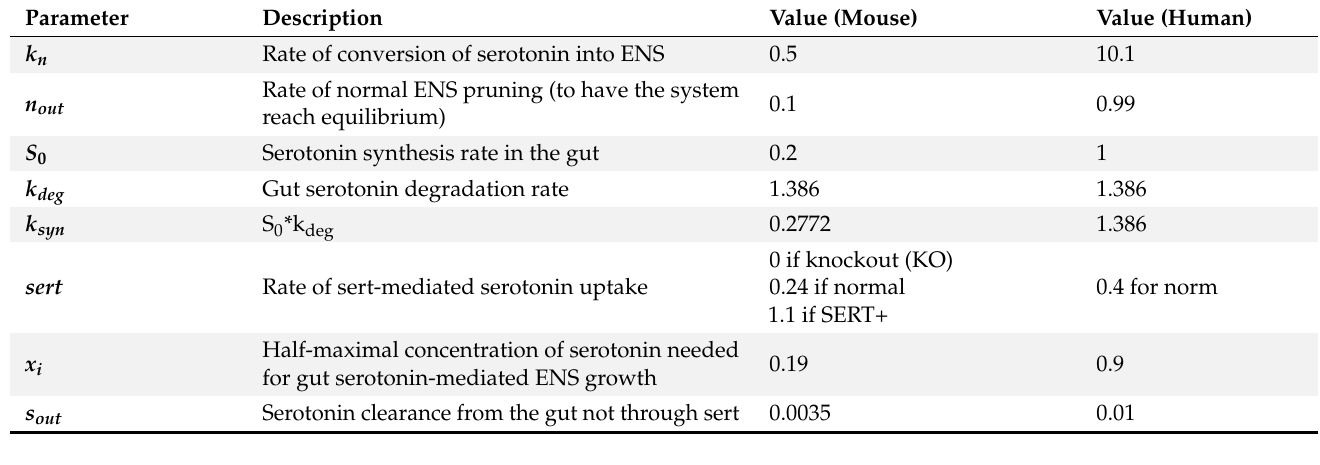
Table 1. Parameter values used in simulations for both mouse and human dynamics.